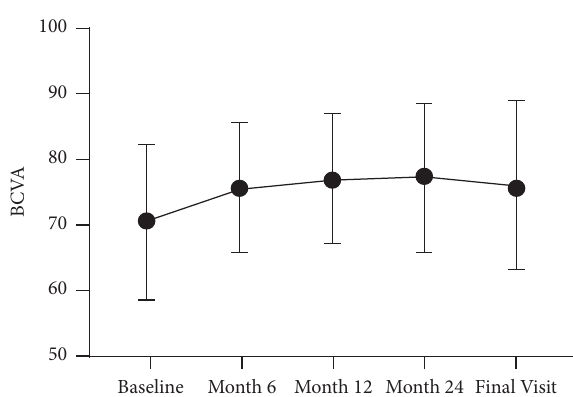
Figure 2: BCVA over the observation period of all patients who completed the study.